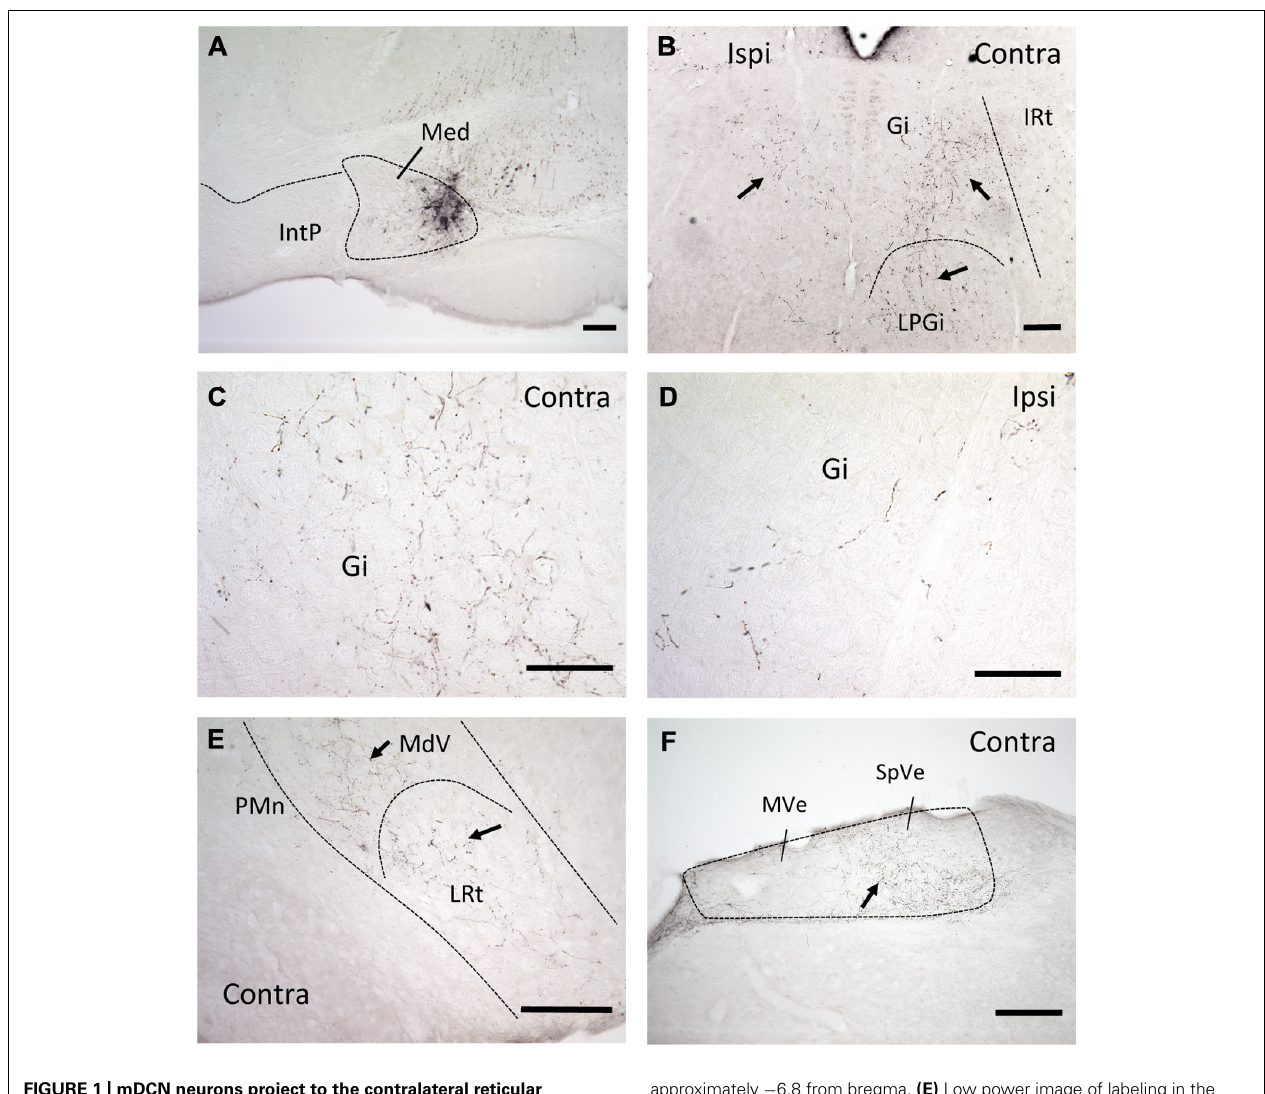
approximately − 6.8 from bregma. (E) Low power image of labeling in the caudal brainstem, in the contralateral MdV and LRt, approximately − 7.3 mm from bregma. (F) Labeling in the contralateral vestibular nucleus, approximately − 7.0 from bregma.With the exception of (F) , all images were prepared from a single mouse brain. Scale bars: (A,B,E,F) = 200 μ ; (C,D) = 100 μ . Arrows point to examples of terminal/axonal labeling in lower power